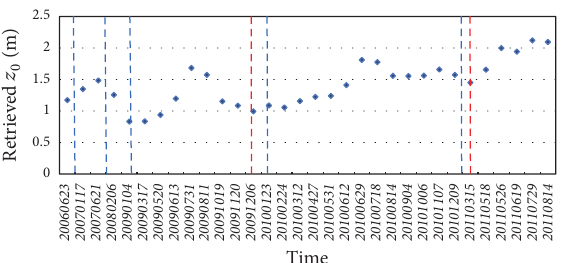
Figure 12: The temporal variation of 𝑧 0 in the northeast of Beijing city extracted from time series of ALOS PALSAR and COSMO-SkyMed data from 2006 to 2011. The blue lines indicate the beginning of the year, and the red lines indicate the period when buildings dramatically increased.